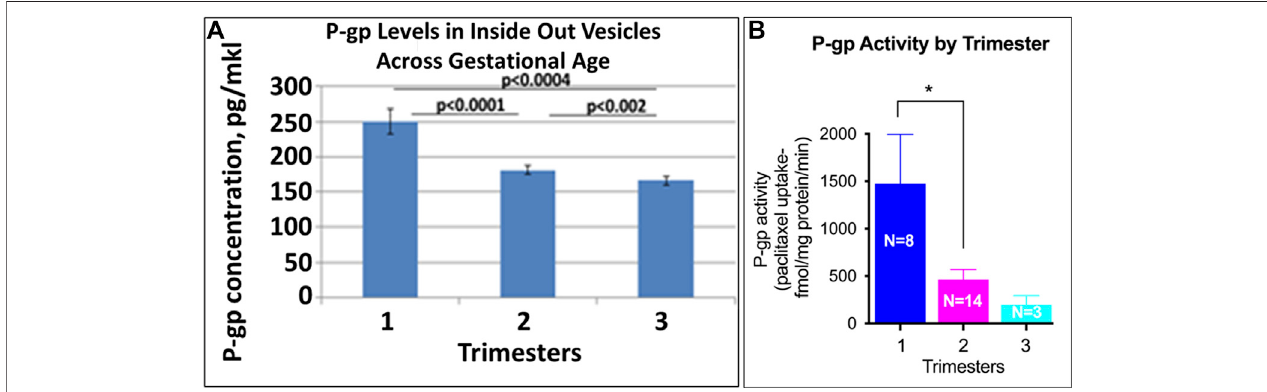
FIGURE 7 | Placental P-gp activity across GA. Levels of P-gp in IOV were assayed by ELISA ( A ; pg/mkl of vesicles). P-gp speci fi c [ 3 H]-paclitaxel transport was validated in the presence and absence of ATP generating media and the ability of P-gp inhibitor, verapamil to block [ 3 H]-paclitaxel transport (B) . Symbols represent the following levels of statistical signi fi cance: * p <